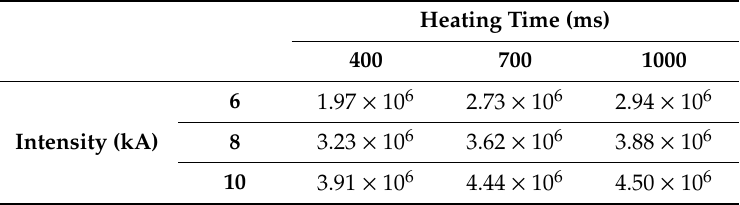
Table 4. Values of electrical conductivity σ , expressed in ( Ω · m) − 1 , for the di ff erent MF-ERS compacts.